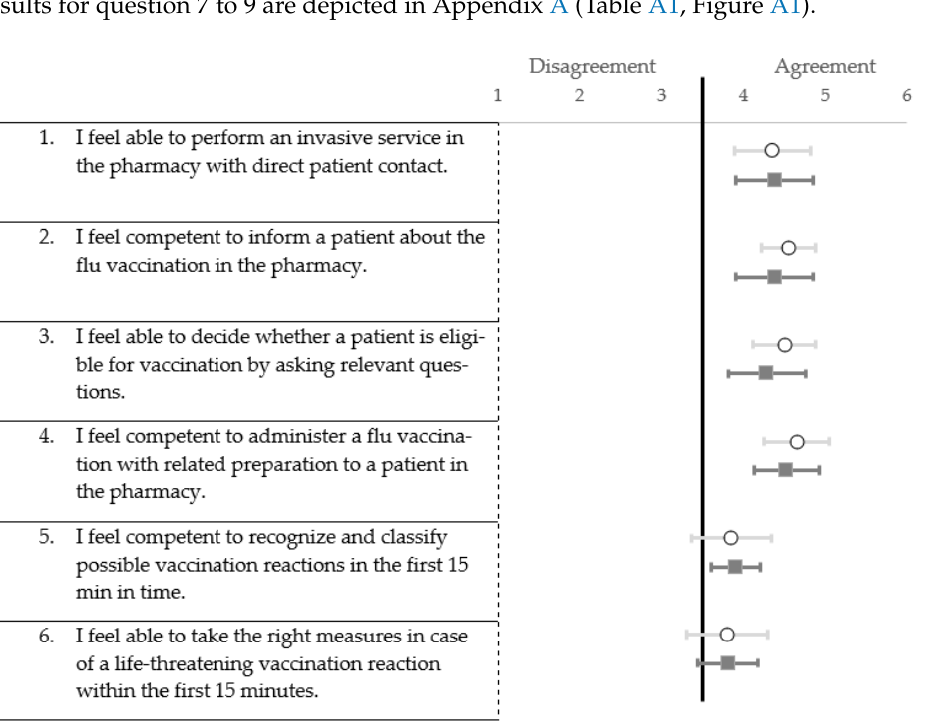
n = 21 each for intervention and control group.